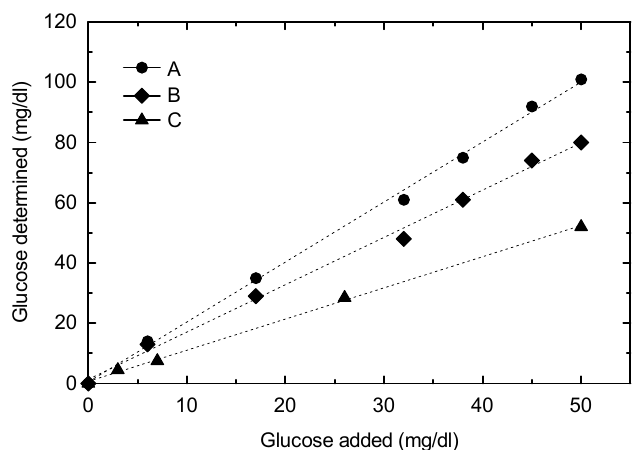
Fig. 3: Influence of the sample matrix on the glucose concentration values measured with a blood glucose meter. A – Glucose dissolved in pure water (y = 2.0 x; r 2 = 0.99); B – Glucose dissolved in water and treat- ed with myrosinase solution (y = 1.6 x; r 2 = 0.99); C – Glucose dis- solved in horseradish extract and treated with myrosinase solution. The glucose concentration originating from the extract is eliminated by subtraction. (y = 1.1 x; r 2 = 0.99).